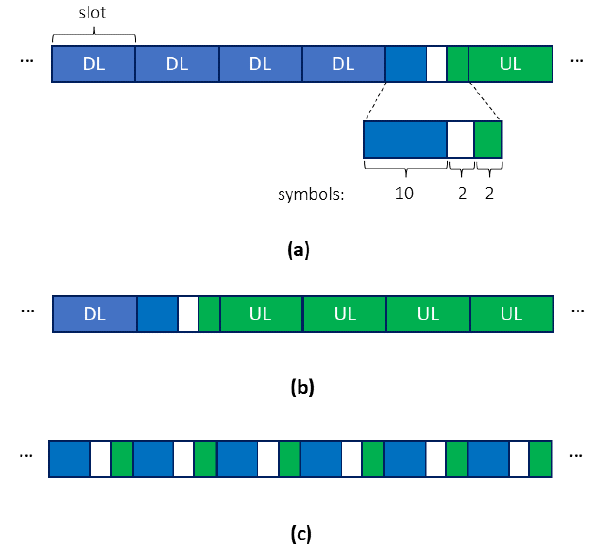
Figure 1. Different TDD structures: ( a ) for heavy DL traffic, ( b ) for heavy UL traffic, ( c ) for mixed traffic or frequent UL